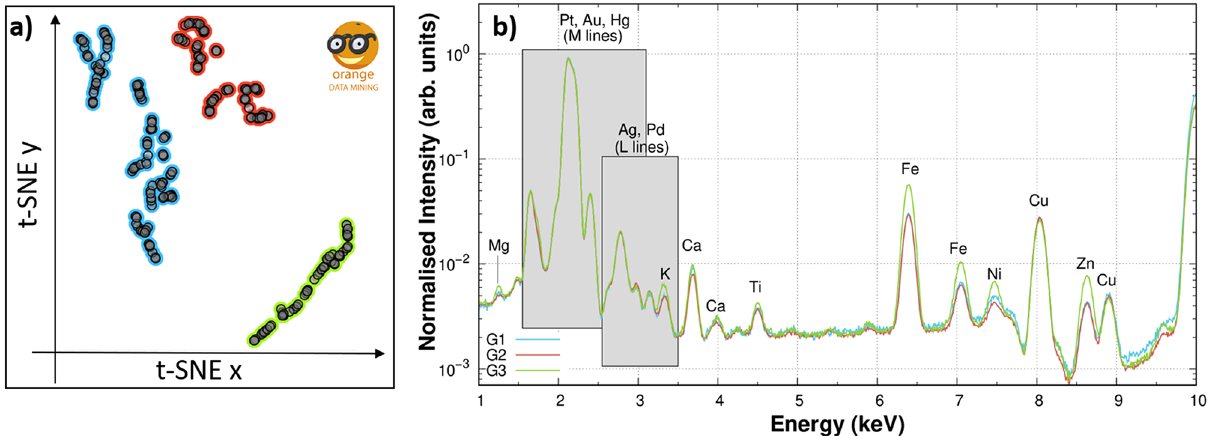
Figure 2. (a) t-SNE plot of the XRF map obtained with 10 keV on coin B. Three groups are identified: blue G1, red G2, and green G3. (b) The spectra of the three groups collected with an incident energy of 10 keV are shown upon normalisation to the Au emission peak at 2.1 keV. Each peak is identified with the element giving rise to that spectral feature.